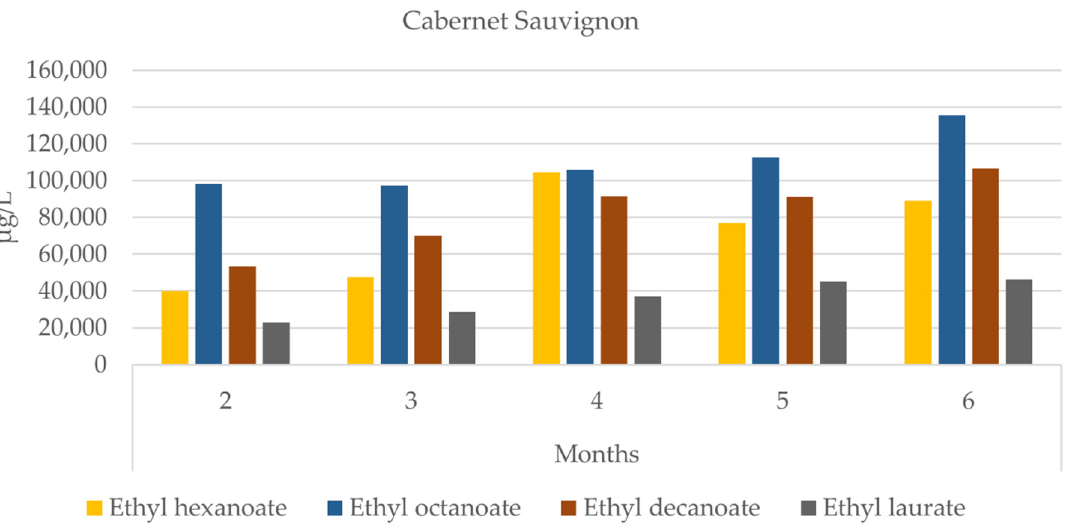
Figure 1. Changes in esters concentration in ‘ Cabernet Sauvignon’ brandy during six months ageing in barrique oak barrels.